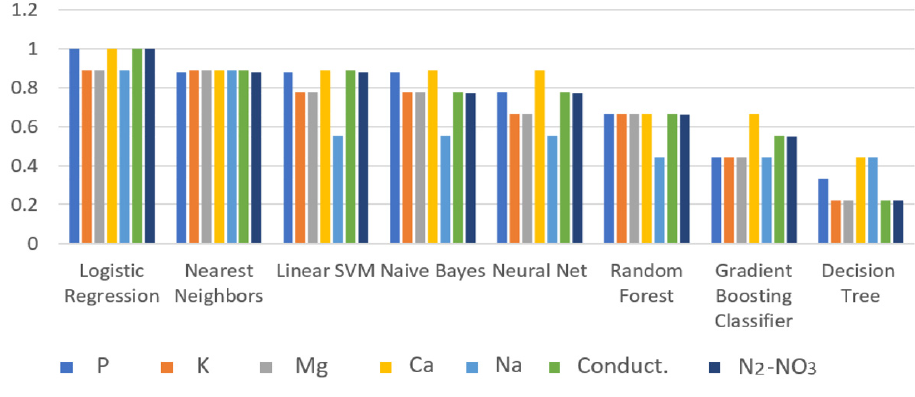
Figure 19. Test score comparison for all of the classifiers.